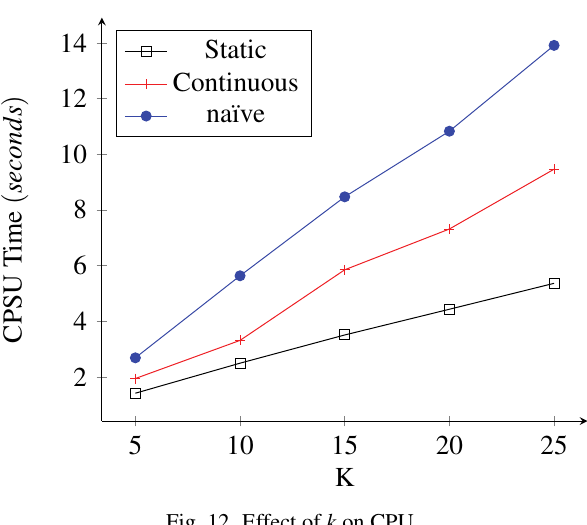
Fig. 12. Effect of k on CPU